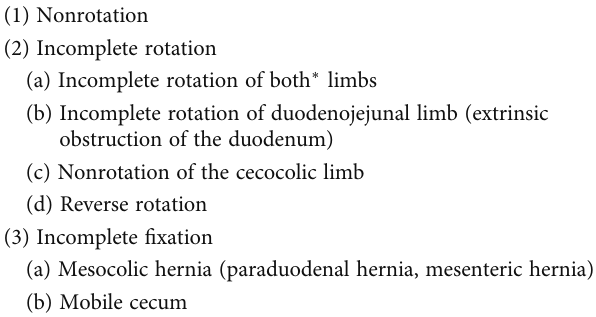
Table 1: The classi fi cation of intestinal malrotation (based on Nishijima ’ s literature